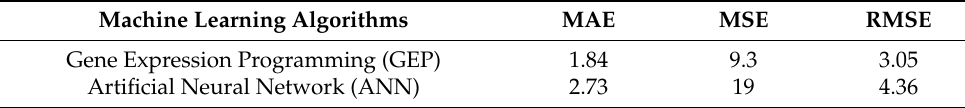
Figure 4. Statistical representation for the k-fold cross-validation process. GEP ( a ); ANN ( b ). Table 2. Statistical checks of the GEP and ANN